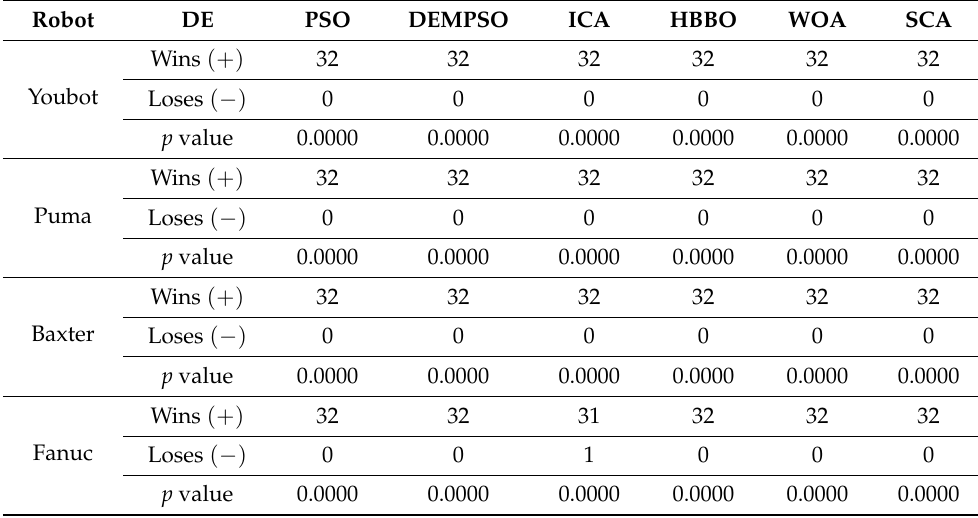
Table 6. Sign test results for the objective function for the circle